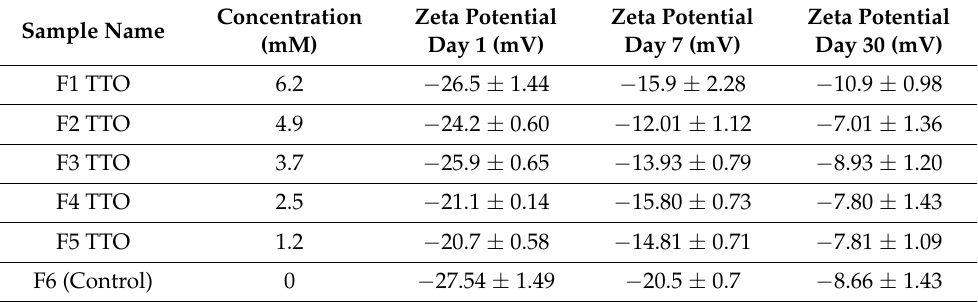
Table 4. Zeta potential values of TTO-loaded nanoliposomes (F1 to F5 fractions) and control sample (F6 fraction) after day 1, 7, and 30 of storage at 4 ◦ C. Data were articulated as mean values ± standard